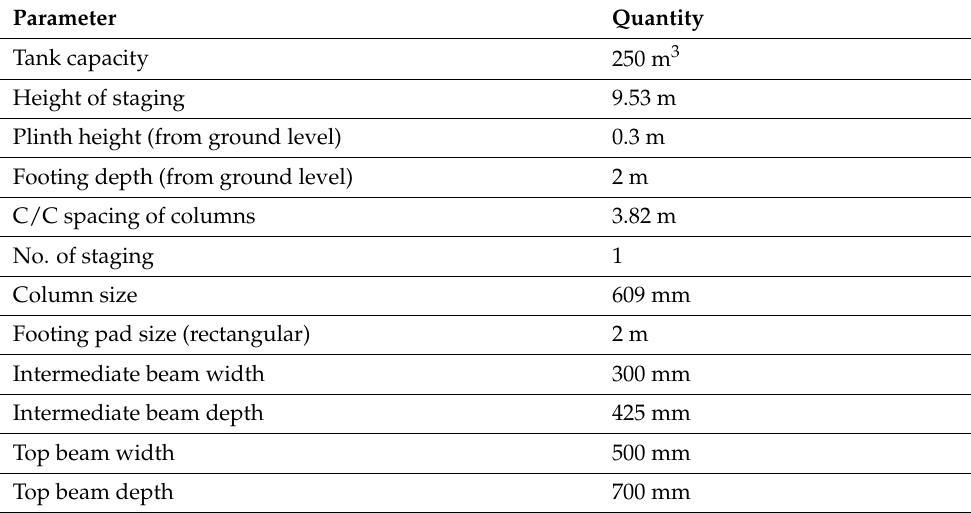
Table 1. Geometrical properties of water tank.